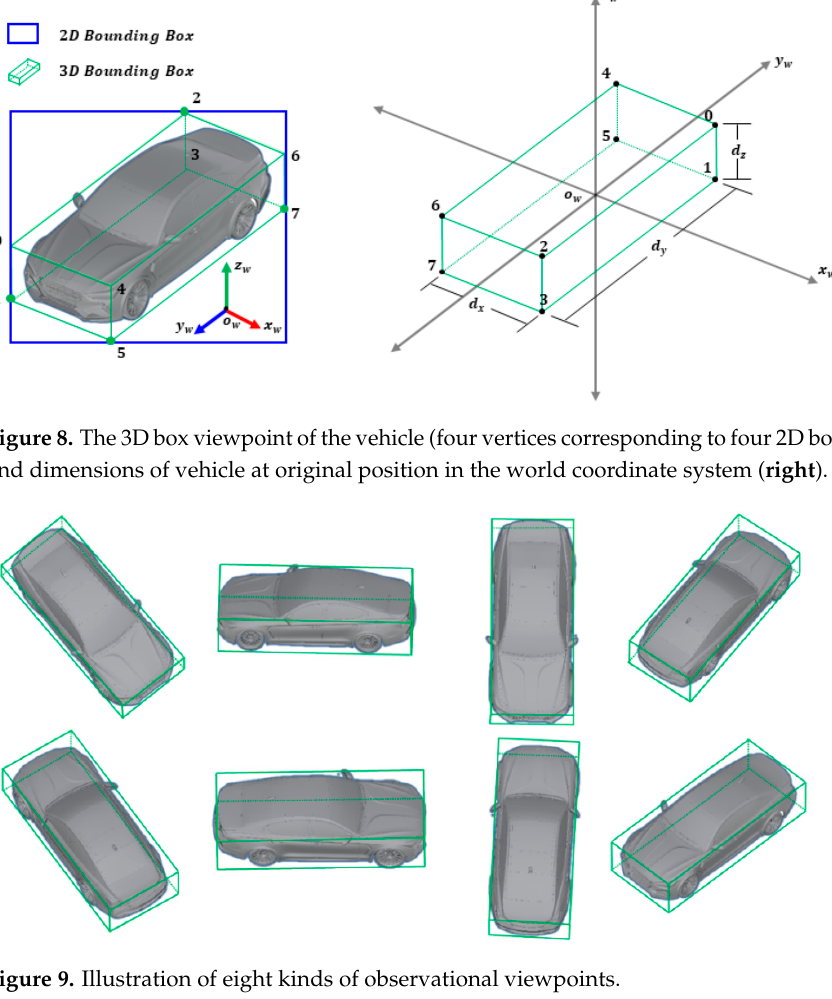
Figure 9. Illustration of eight kinds of observational viewpoints.